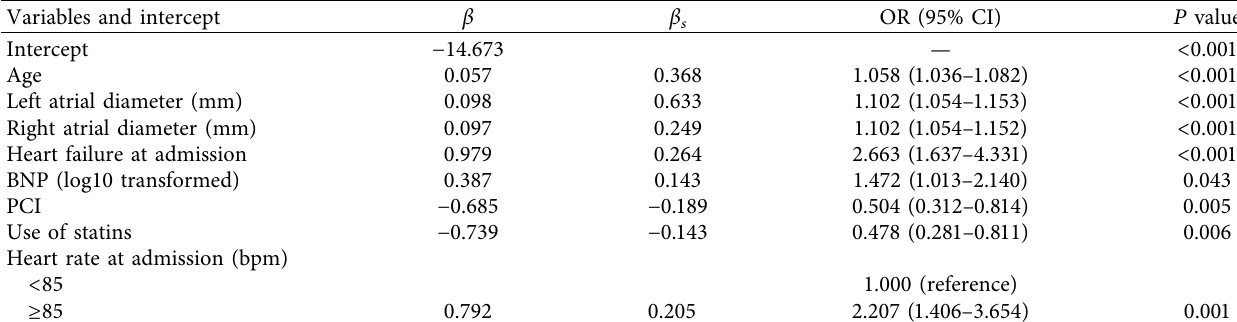
Table 2: Multivariable logistic regression analysis of NOAF in ACS patients.